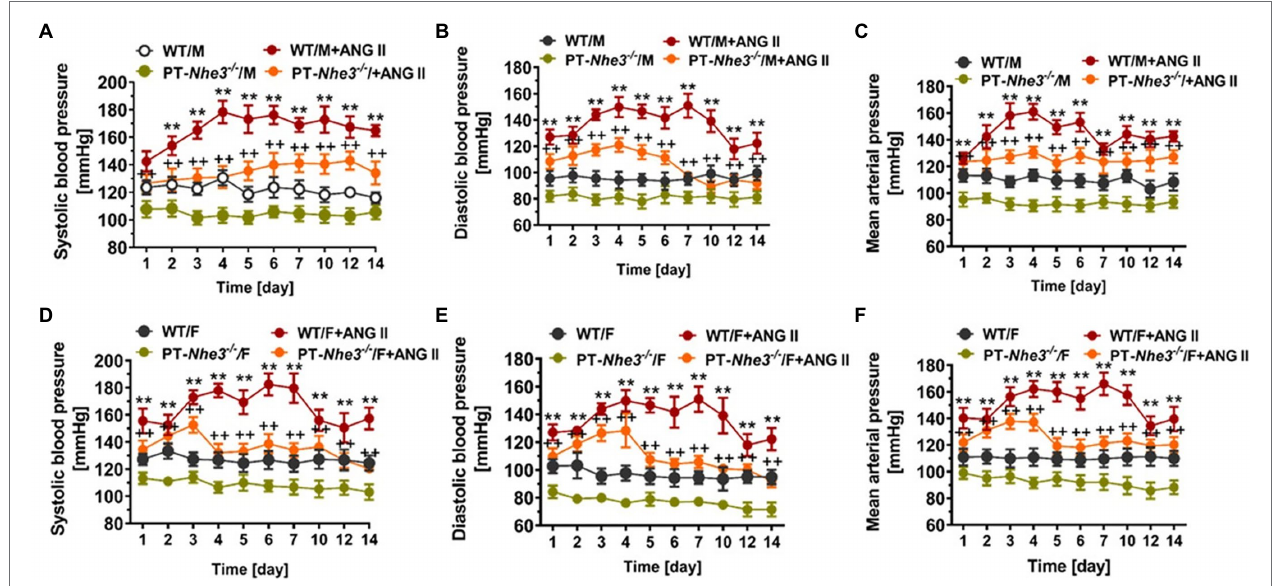
FIGURE 5 | Systolic, diastolic and mean arterial blood pressure responses to a high pressor dose of ANG II infusion, 1.5 mg/kg/day, i.p., in conscious adult male (A-C) and female (D-F) WT and PT- Nhe3 − / − mice, as measured continuously for 14 days using the direct implanted telemetry technique. Note that basal blood pressure levels were about 12–15 mmHg lower in PT- Nhe3 − / − than WT mice, and that Ang II-induced hypertension was attenuated in male (A-C) and female (D-F) PT- Nhe3 − / − mice. ** p < 0.01 vs. WT time-control group; ++ p < 0.01 vs. PT- Nhe3 − / − time-control group, respectively. N = 5–12 per group. Reproduced from Li et al. (2019b) with